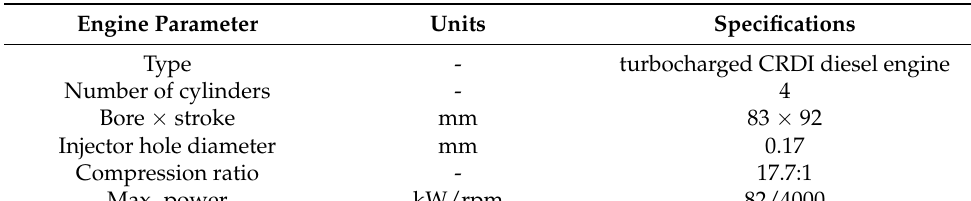
Table 2. Specifications of the test engine.